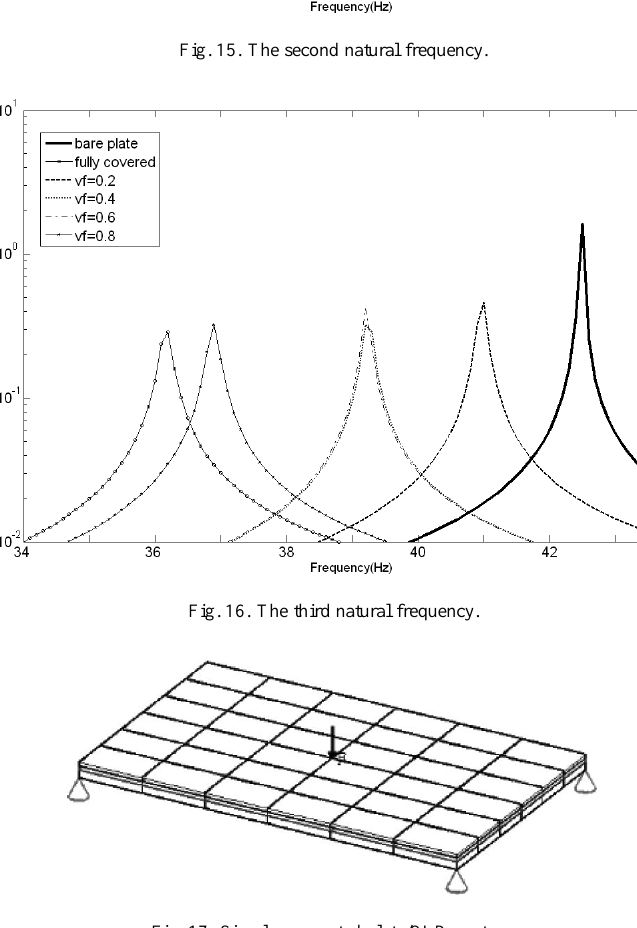
Fig. 17. Simply supported plate/CLD